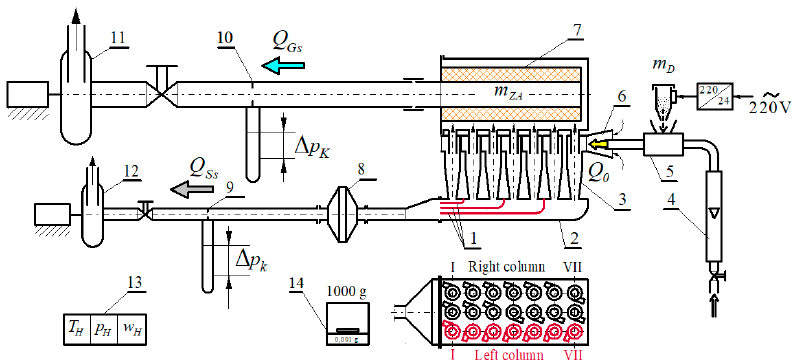
Figure 20. Test stand diagram of the air filter multi-cyclone segment: 1—partitions of dust settling channels, 2—dust settler, 3—cyclone, 4—compressed air stream rotameter, 5—dust dispenser, 6—dust chamber, 7—measuring filter, 8—absolute filter of the suction stream, 9—measuring orifice of the suction stream, 10—measuring orifice of the main stream, 11—suction fans, 12—device for measuring temperature, pressure and humidity of the ambient air, 13—analytical